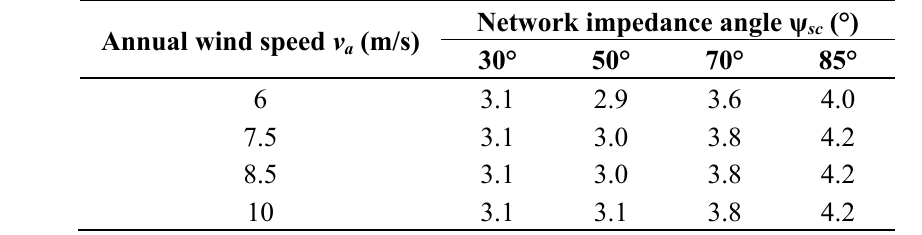
Table 4. Values of the flicker factor for various values of the wind speed v angles ψ sc .